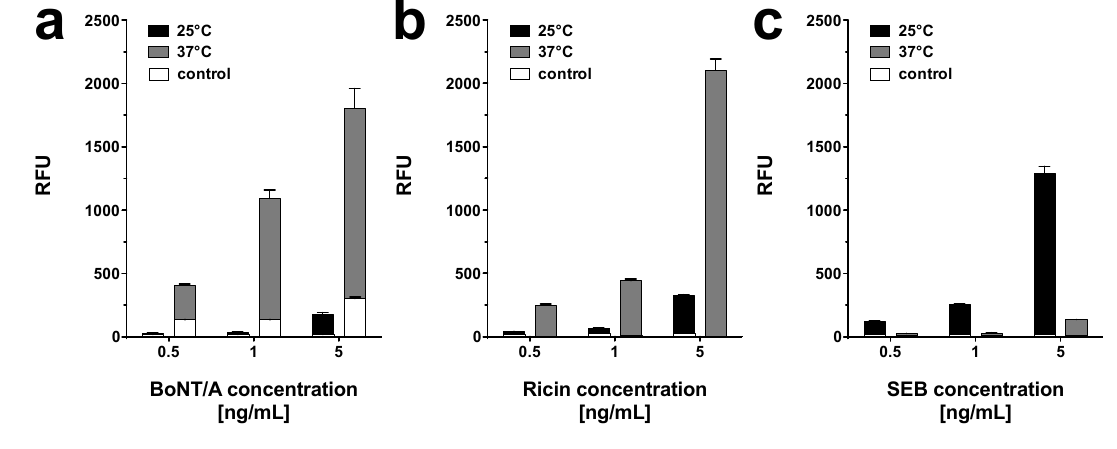
Figure 3. Temperature dependent detection of BoNT/A, ricin, and SEB. PBS was spiked with different concentrations (0.5, 1, and 5 ng·mL − 1 ) of ( a ) BoNT/A, ( b ) Ricin, and ( c ) SEB, respectively, and incubated either at 25 °C (black bars) or at 37 °C (gray bars). Negative control values (white) are integrated in the depicted bars. Average signal intensity and the standard deviation (error bars) were calculated from six features (n = 6) per